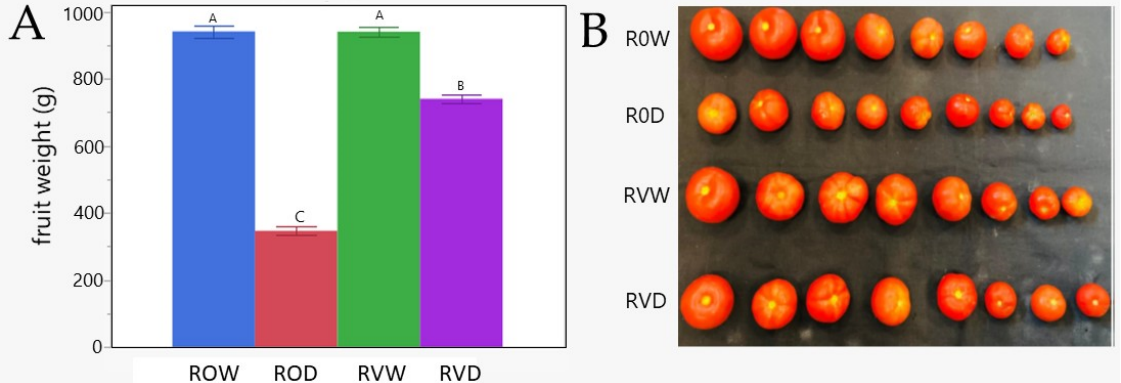
Figure 5. Tomato yield in R-GF967 plants, grown under water deficit, followed by recovery with regular irrigation. After 14 days of growth under drought, R-GF967 plants developed under normal irrigation for another two months. Then all the fruits were collected. ( A ) Average weight of tomato fruits produced by one plant; fruits from five plants randomly collected from each group (HWR, HDR, VWR, and VDR) were gathered, and their fresh weights were measured. Values with deferent letters are significant ( p = 0.05, Student’s t -test). Three independent biological repeats were used with similar results. ( B ) The shape and size of individual fruit from one R0W, R0D, RVW, RVD of R-GF967 plant were compared.